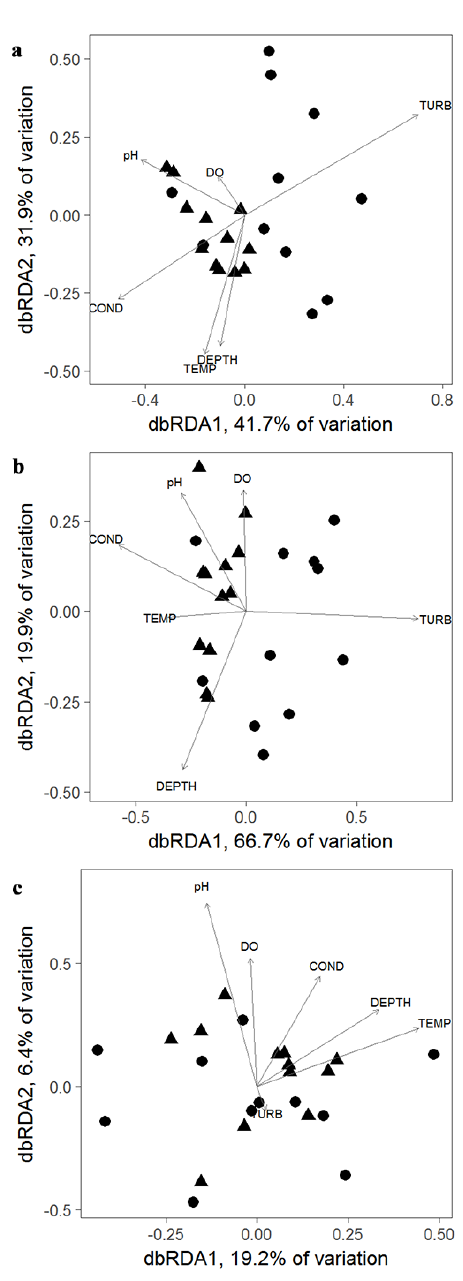
Figure 4. Distance-based Redundancy Analysis (dbRDA) of species assemblages and environmental variables in the Upper Paraná River. (a) Total Bray Curtis; (b) Turnover and (c) Nestedness. Circles: Paraná River sites; Triangles: Tributaries. TEMP: water temperature; mean